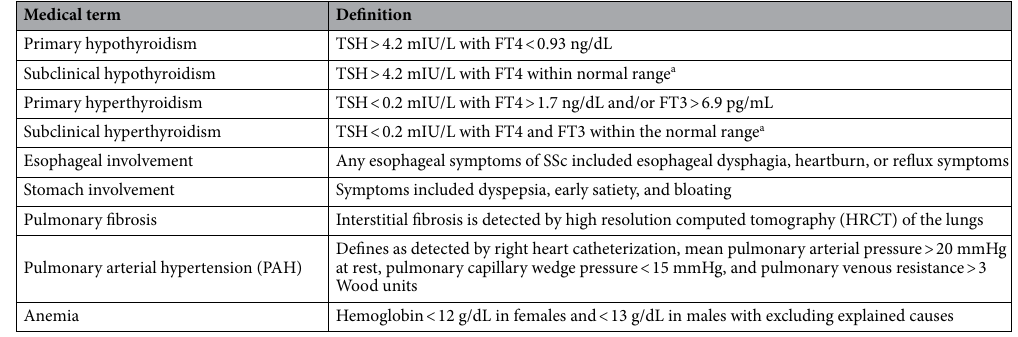
Table 1. Definition of clinical parameters determined from medical records and criteria for diagnosis of thyroid. TSH thyroid stimulating hormone; FT3 free triiodothyronine; FT4 free thyroxine. a Normal range